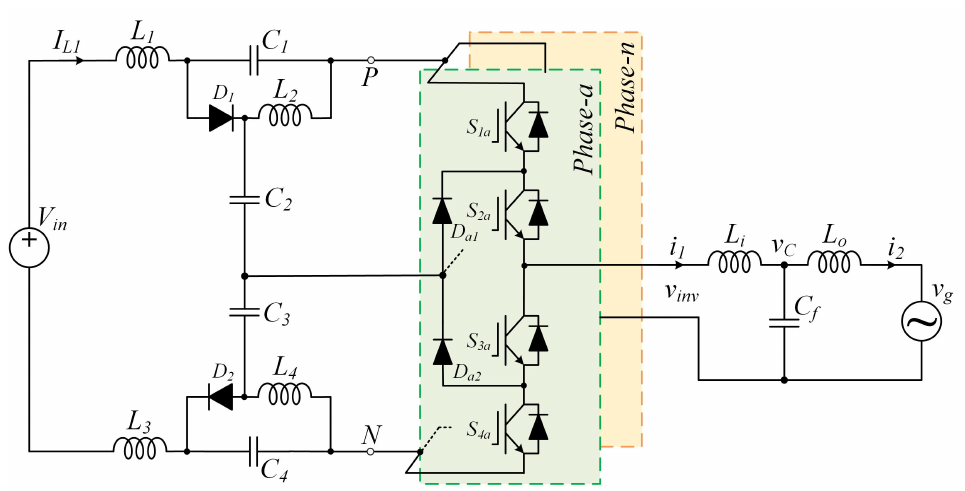
Figure 1. The Single-phase grid-connected NPC-qZSI with LCL filter [3,32].